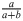
Effect of population size on the magnitude of distortion.Indicated in the header of each panel is the population size. Segregation ratio is calculated as aa+b, and each data point is the mean value over 1000 simulations. The simulations have no selection and use the marker distribution from chromosome 1A of the Cadenza x Avalon cross. The shaded area represents the mean segregation ratio value ± the standard deviation over 1000 simulations. The dashed lines mark the 5% significance threshold for a chi-square test, whilst the dotted line marks a 1:1 segregation ratio. The effect of sampling error on segregation ratio decreases as population size increases.